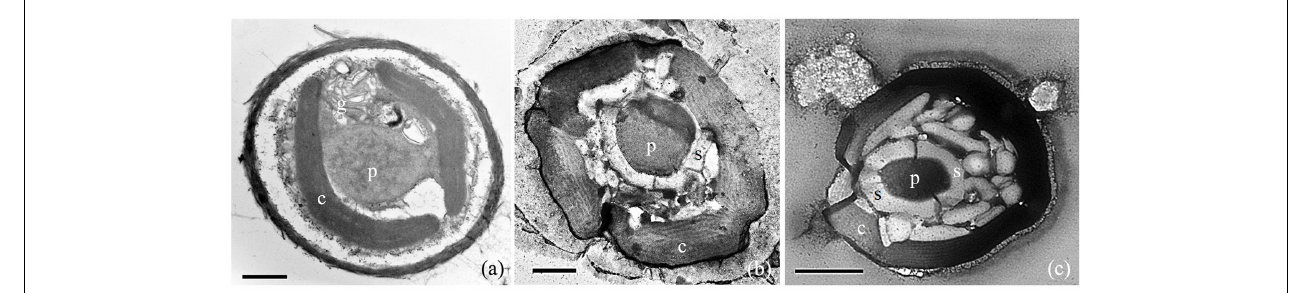
FIGURE 3 | TEM photomicrographs of Rhodosorus marinus cells taken from cultures established from individual cells removed from Lithothamnion sp. rhodolith. (a) Two crescent-shaped chloroplast lobes (c), a stalked pyrenoid (p), and golgi apparatus (g); (b) five chloroplast lobes (c) and a central pyrenoid (p) surrounded by floridean starch (s); (c) copious amounts of floridean starch granules (s) surrounding the pyrenoid (p), and chloroplast lobes (c). Scale bars: (a) = 1 µ m, (b) = 0.5 µ m, (c) = 1 µ m.